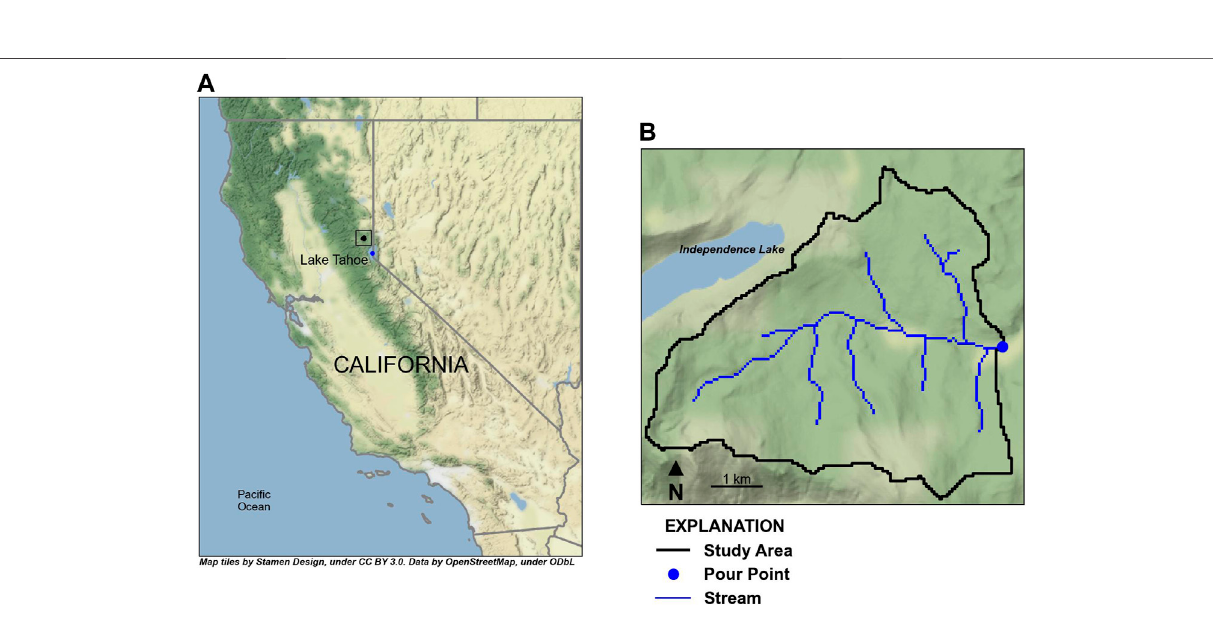
FIGURE 6 | Location of the Sagehen Creek watershed study area near Lake Tahoe, California, in the northern Sierra Nevada (A) ; the study area extent (black outline), Sagehen Creek watershed streamlines (blue lines), and USGS streamgage (10,343,500 SAGEHEN C NR TRUCKEE CA; U.S. Geological Survey, 2021; blue marker) is shown in (B)